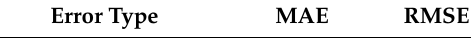
Figure 7. Terminal voltage error. Table 4. Model error parameters.